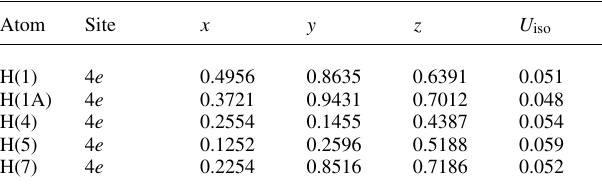
Table 2. Atomic coordinates and displacement parameters (in Å 2 )